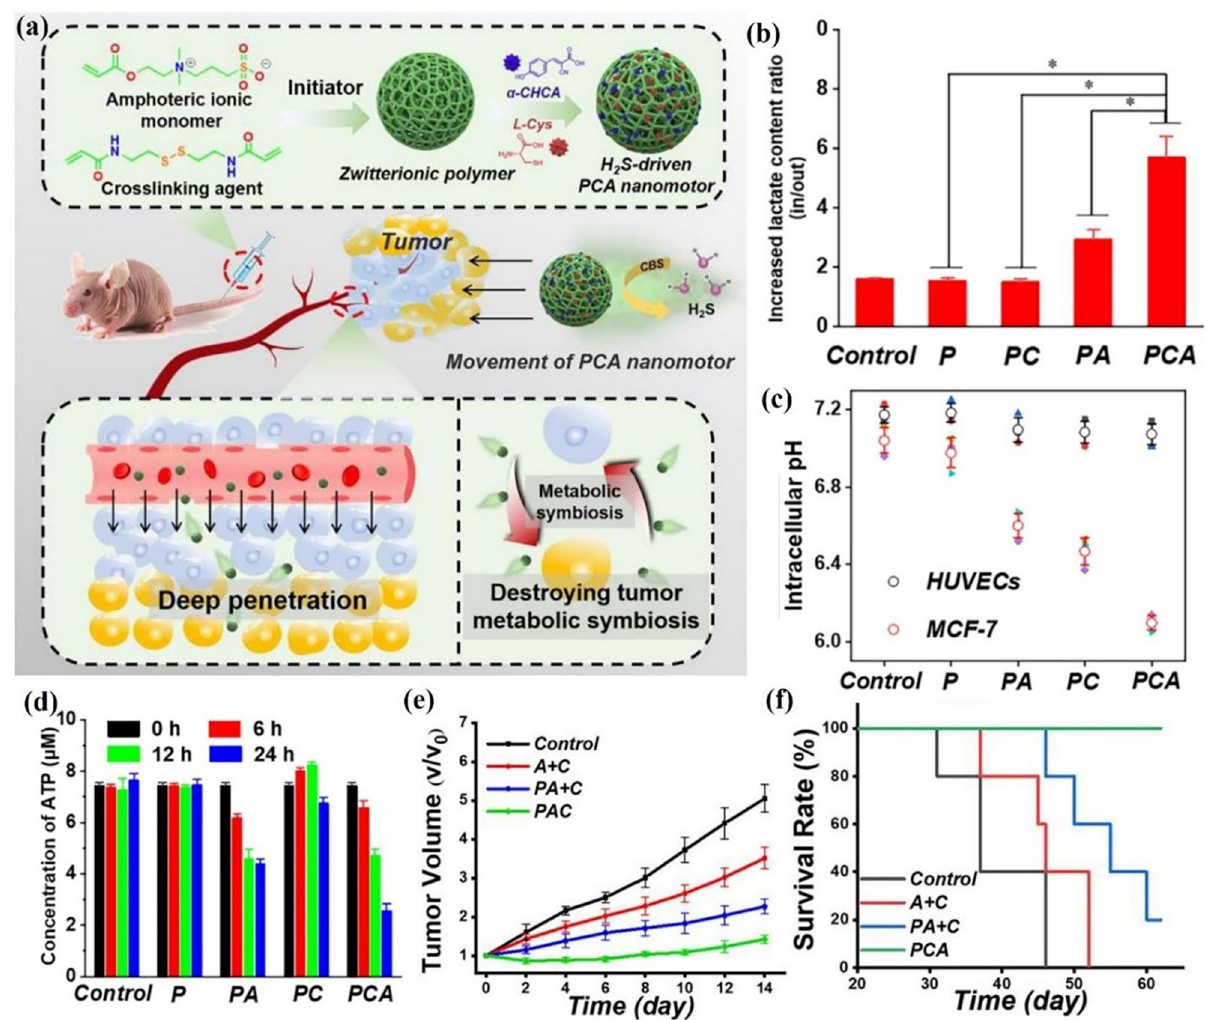
Figure 5: ( a ) Schematic illustration of the synthetic process and action of PCA nanomotor. ( b ) Increased intracellular and extracellular lactate content ratio in di ff erent treatment groups. ( c ) The pH of MCF - 7 and HUVECs cells after a 24 h treatment with di ff erent groups. ( d ) The ATP level in MCF - 7 cells after a 24 h incubation with di ff erent treatment groups. ( e ) The change in tumor volumes of mice during di ff erent treatments. ( f ) The survival rate of mice in 62 days. Reprinted with permission from Ref. [ 91 ] ; Copyright © 2021 Wiley -